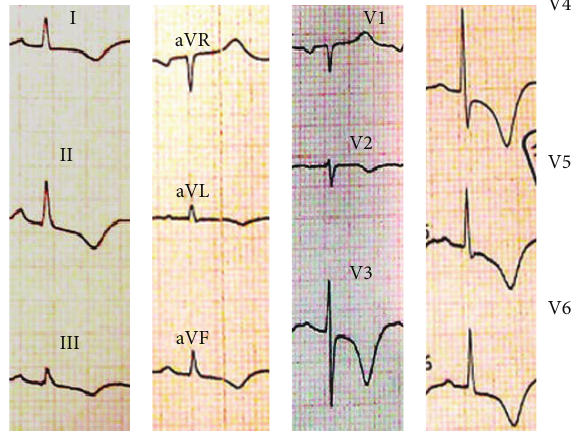
Figure 4: The electrocardiogram at 2nd day of admission revealing “mild” T-wave inversion at leads I, II, III, aVL, aVF, and V4–V6.